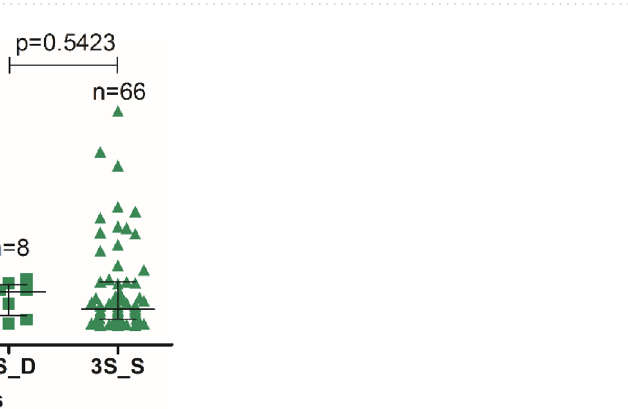
Figure 2. Box and whiskers plot showing the relationship between reactivity to 3S and EC26 and viral load ( A ) and proviral load ( B ). Lines denote median, maximum and minimum values. Median values were compared using the Mann–Whitney test.